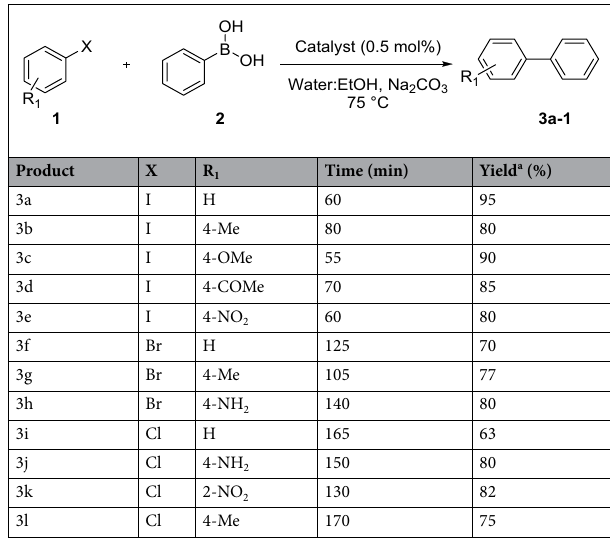
Table 1. Pd@h-Fe 2 O 3 @C catalyzed Suzuki–Miyaura reaction of various aryl halides with boronic acid. Reaction condition: aryl halides (1.0 mmol), boronic acid (1.2 mmol), Pd@h-Fe 2 O 3 @C (0.5 mol%), Na 2 CO 3 (2.0 mmol) in water:EtOH (5.0 mL) at 75 °C. a Isolated yields.